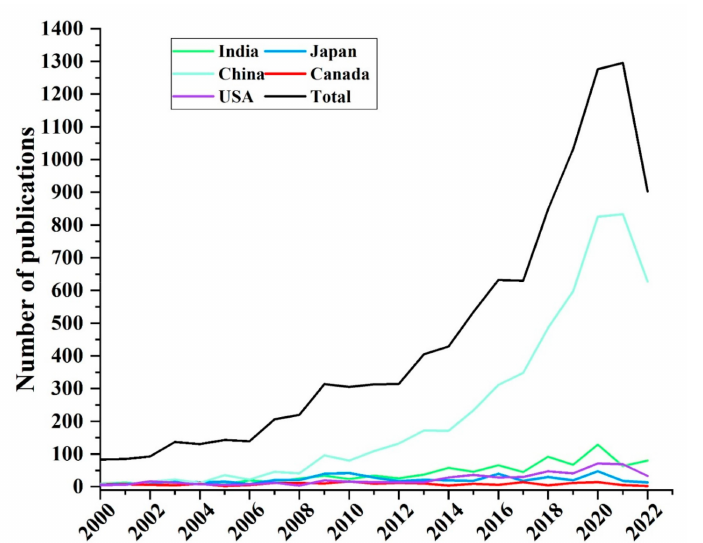
Figure 6. Annual trends in literature on cadmium pollution in rice and wheat cropping system from 2000 to